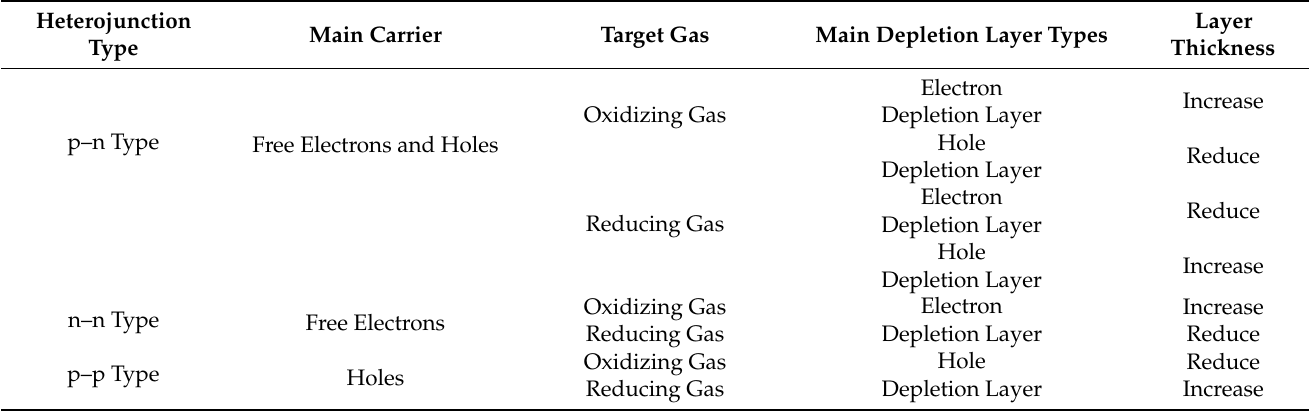
Table 4. Variation of depletion layer thickness in oxidizing gas and reducing